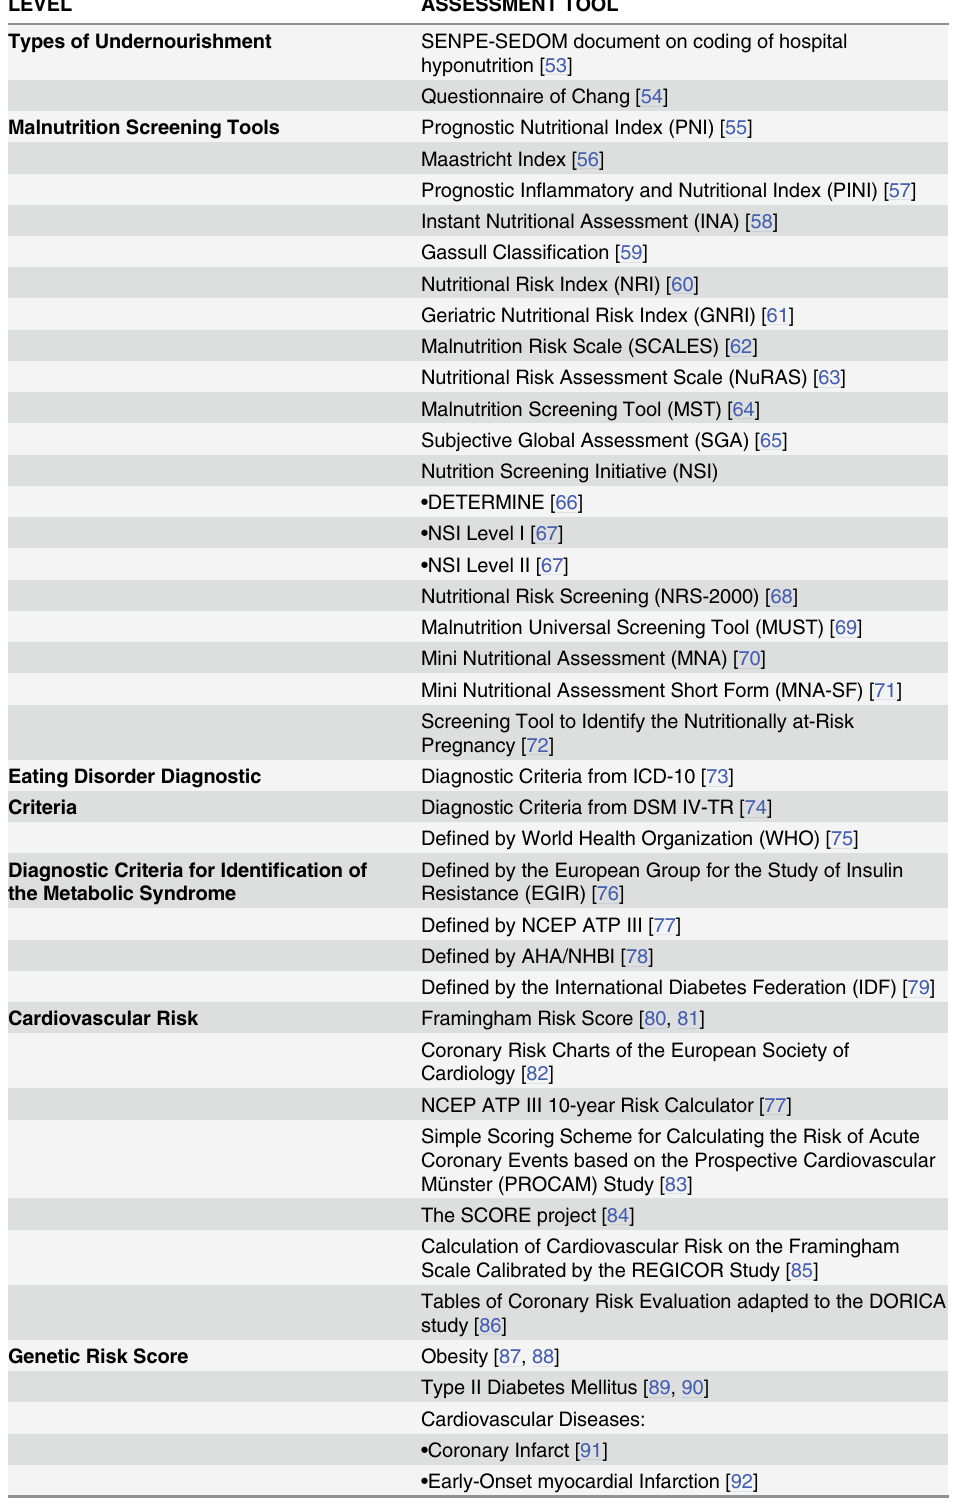
Table 2. Assessment tools of the module of